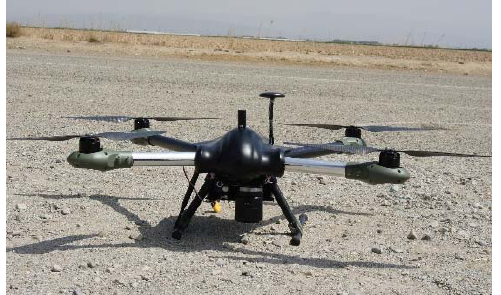
Figure 1. The platform, equipped with onboard navigation and imaging sensors